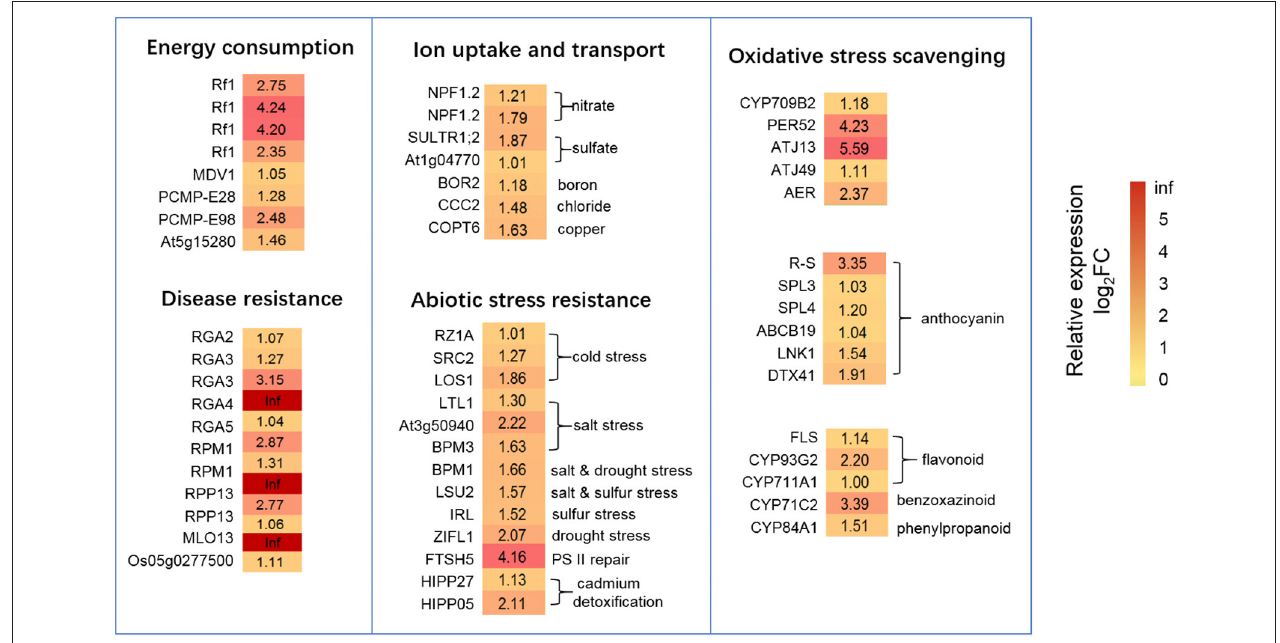
FIGURE 7 | DEGs related to energy consumption, ion uptake and transport, disease resistance, abiotic stress resistance, and oxidative stress scavenging under N starvation conditions. The relative expression levels as described by log 2 FC (FC is the fold change of RPKM means N0/Nck) are represented by a color gradient from low (green) to high (red). Under N-starvation conditions, the DEGs with log 2 FC > 0 represent up-regulated expression, log 2 FC < 0 represents down-regulated expression, and log 2 FC = 0 represents unchanged